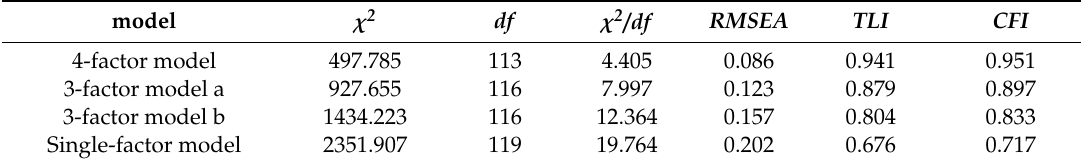
Table 1. Results of confirmatory factor analyses